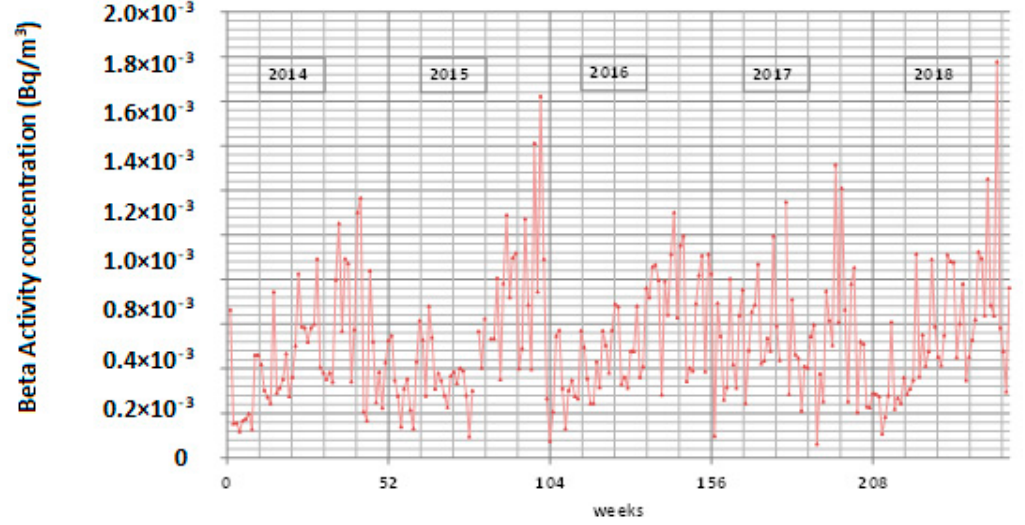
Figure 3. Temporal distribution of weekly beta activity concentrations over the period 2014–2018 in Bilbao.